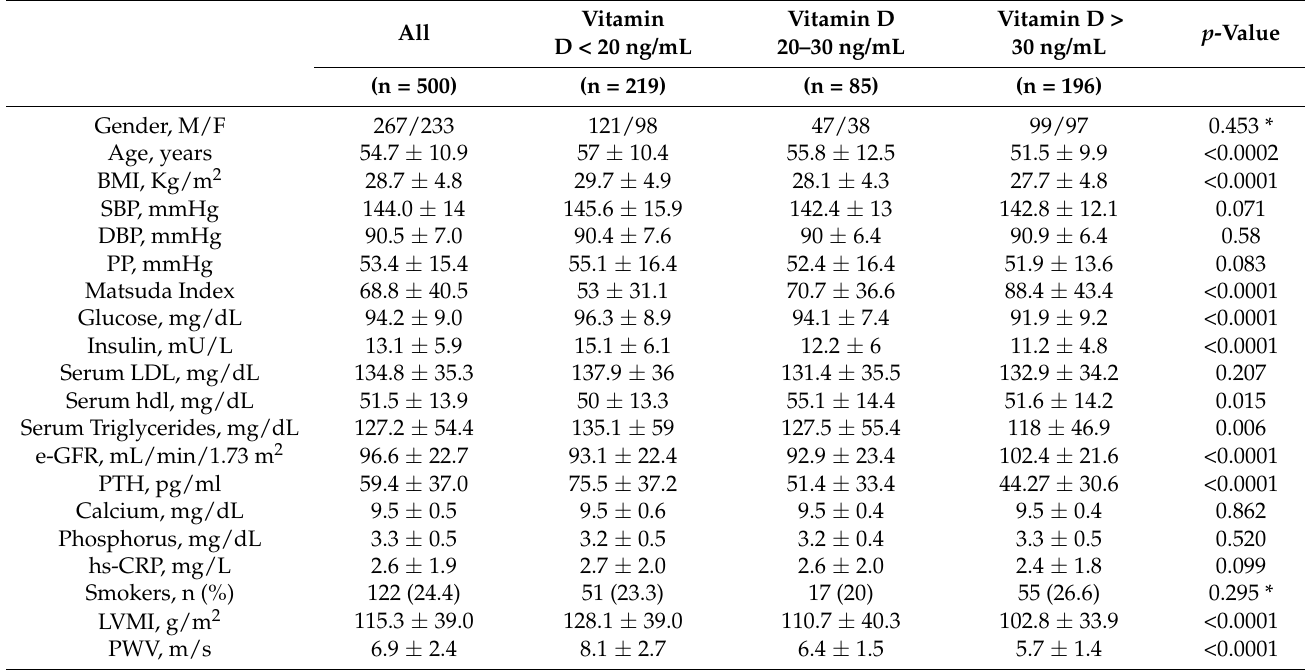
Table 1. Anthropometric, hemodynamic and biochemical characteristics of study population according to Vitamin D levels.